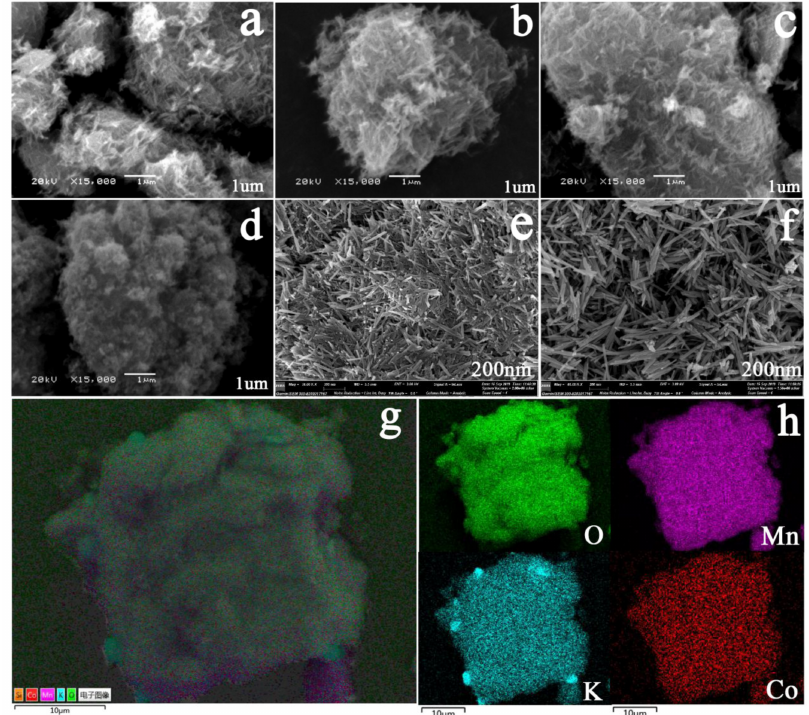
Figure 4. ( a ) Scanning electron microscopy (SEM) of Co 0.1 -OMS-2, ( b ) Co 0.2 -OMS-2, ( c ) Co 0.3 -OMS-2, ( d ) Co 0.4 -OMS-2, ( e ) pure OMS-2, ( f ) Co 0.3 -OMS-2, ( g , h ) the energy dispersive spectrum (EDS) of Co 0.3